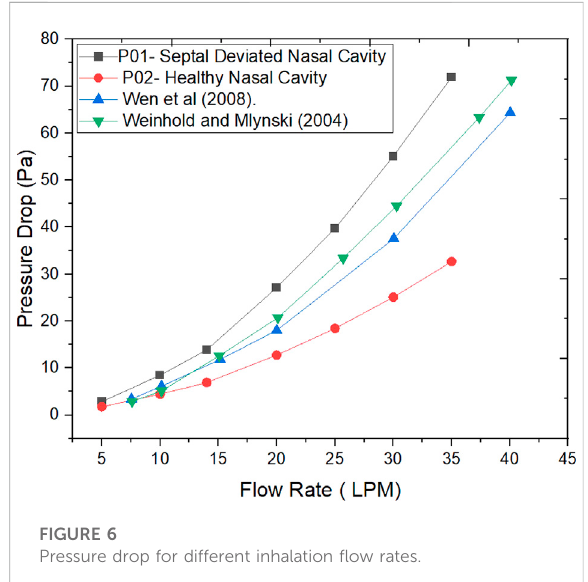
FIGURE 6 Pressure drop for different inhalation fl ow rates.